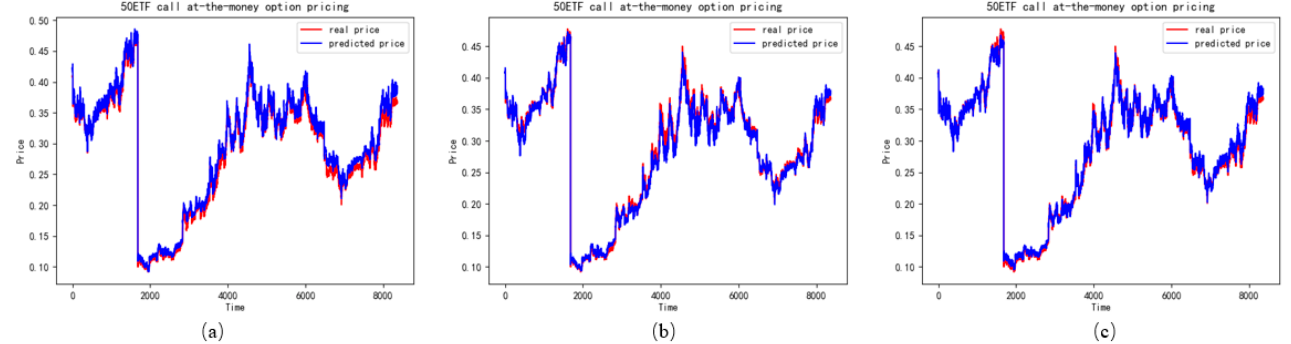
Figure 8. The performance of ATM call options in different features ( a ) represents the LSTM with realized skewness, ( b ) represents the LSTM without realized skewness, ( c ) represents the LSTM with realized skewness and realized kurtosis.